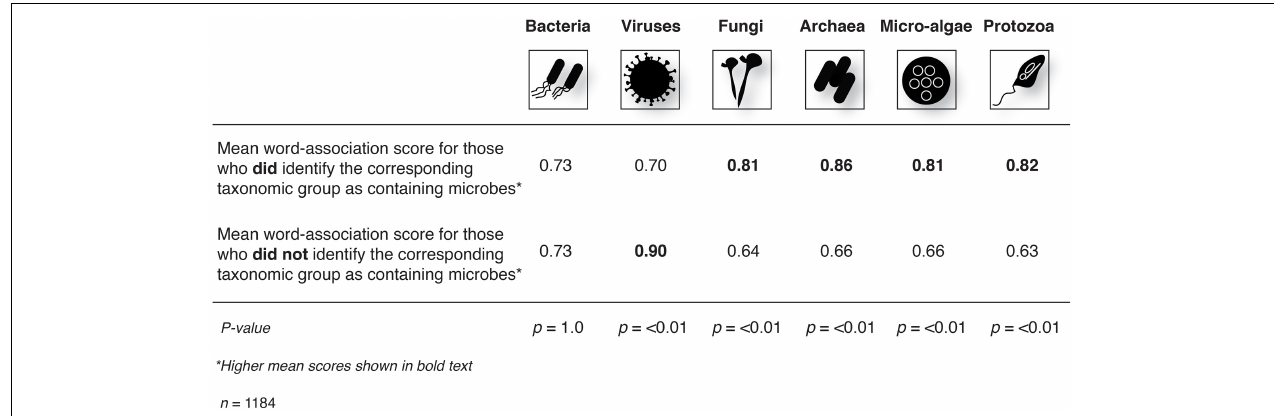
FIGURE 4 | Differences in mean microbe word-associated scores for respondents who correctly identified a given taxa as being a microbe compared to those who did not identify the taxa as being a microbe. There were significantly higher (in positivity) word-association scores for respondents who correctly identified that fungi, archaea, micro-algae, and protozoa are microbes compared to those who did